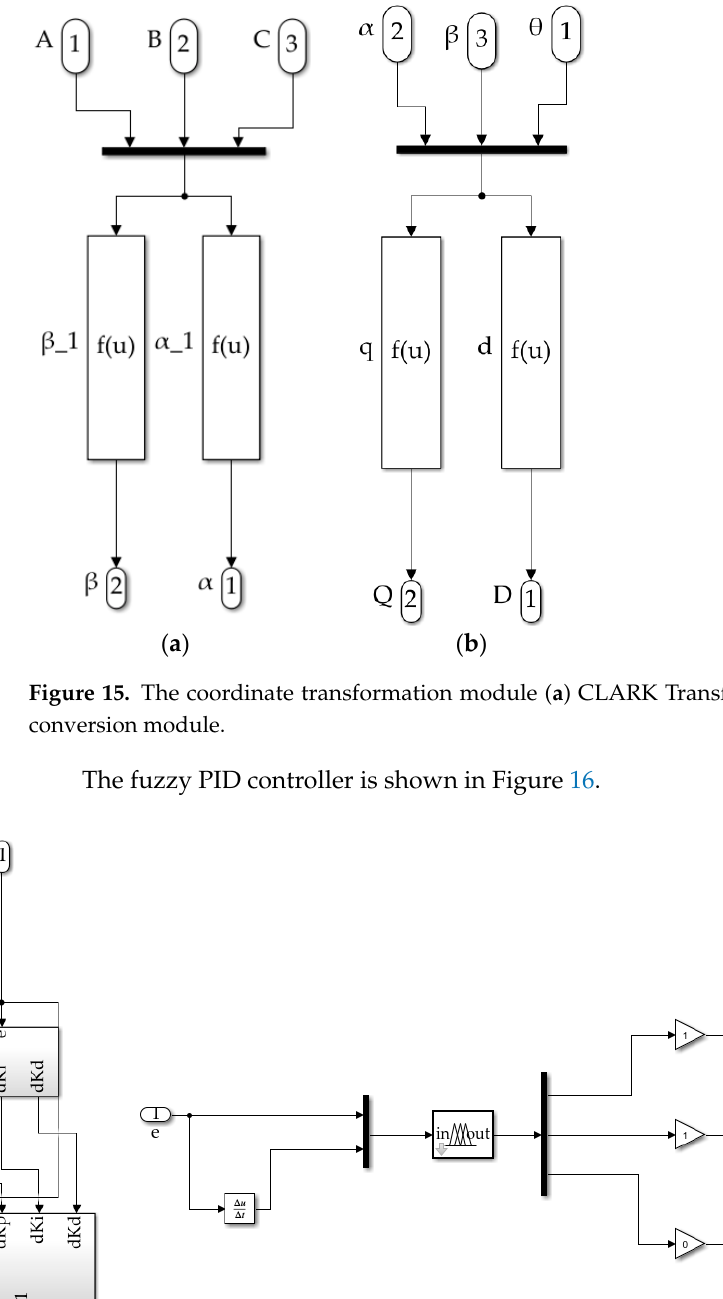
Figure 16. Fuzzy PID controller ( a ) PID control module ( b ) Fuzzy control module.